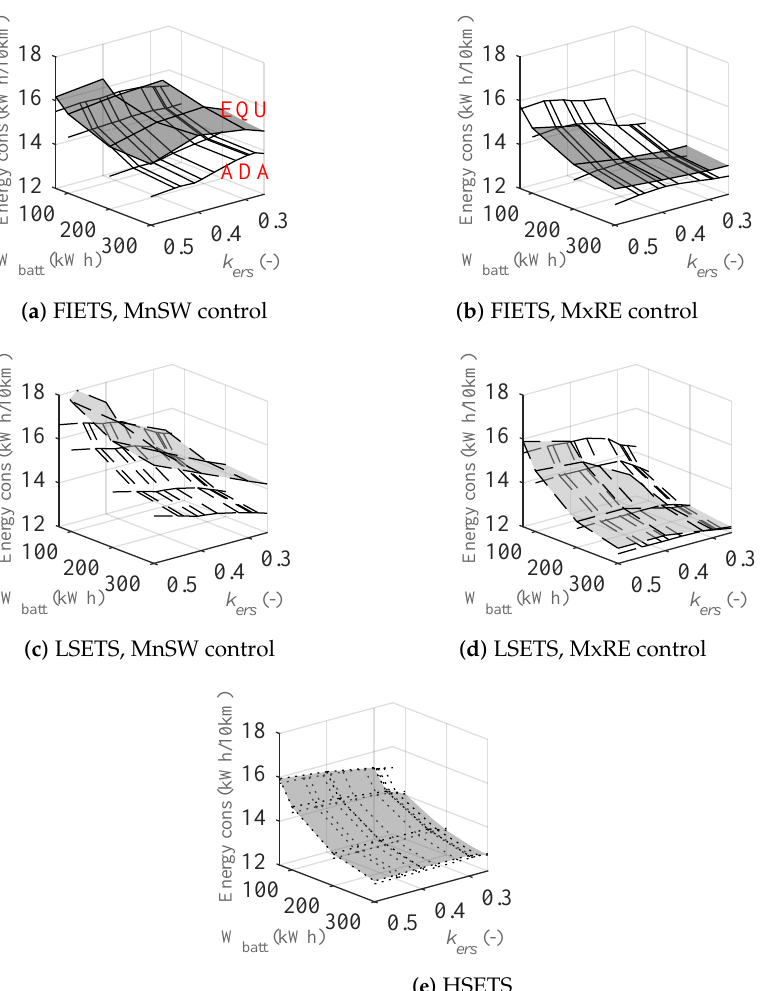
Figure 10. Energy consumption (kWh/10km) of a city bus on ‘City bus route 85’, as a function of the battery capacity, W batt , and the ratio of ERS-coverage, k ers , with d ers = 1 km. The filled surface corresponds to the EQU placing method whilst the non-filled corresponds to the ADA placing method of the ERS.